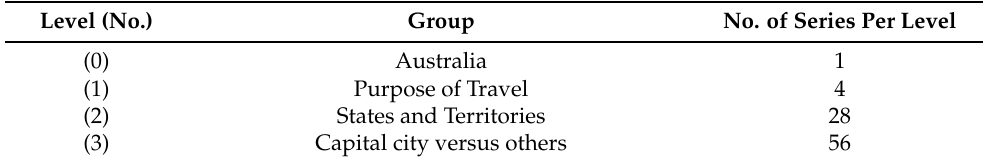
Table 2. Dataset-II: Australian domestic tourism hierarchy data structure. Level